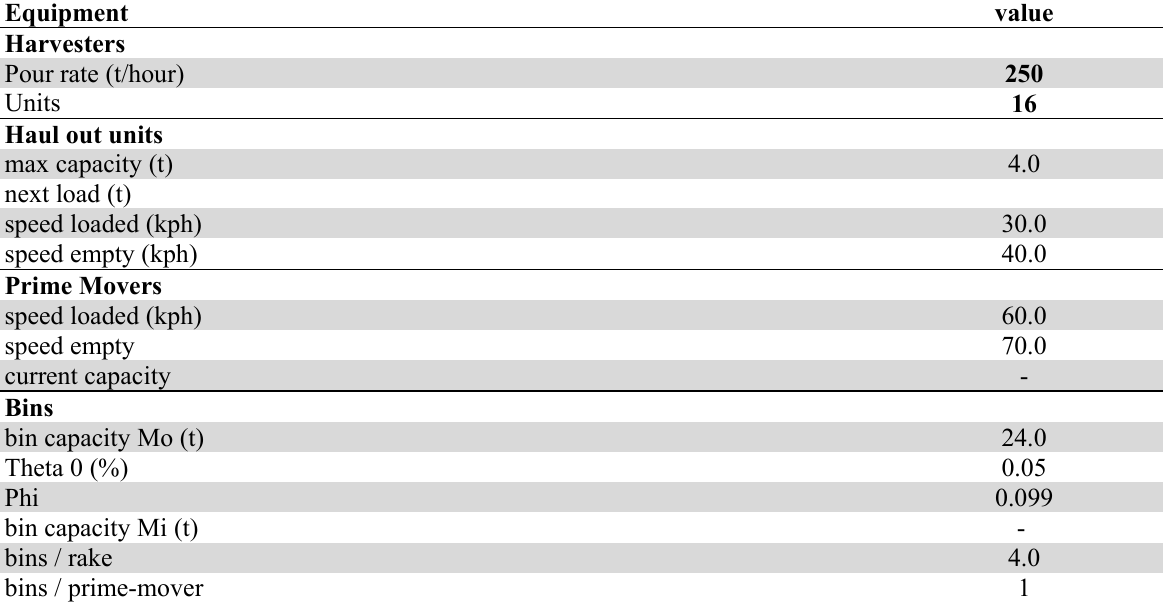
Transportation model parameters input